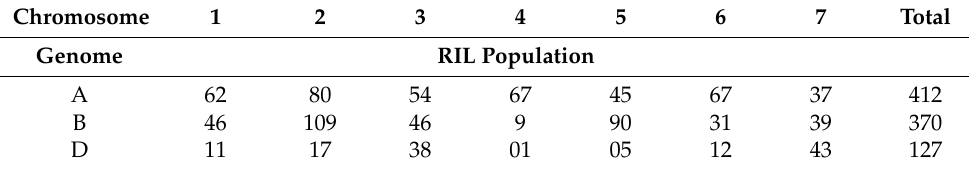
Table 3. Chromosome and subgenome-wise distribution of markers in the RIL population.